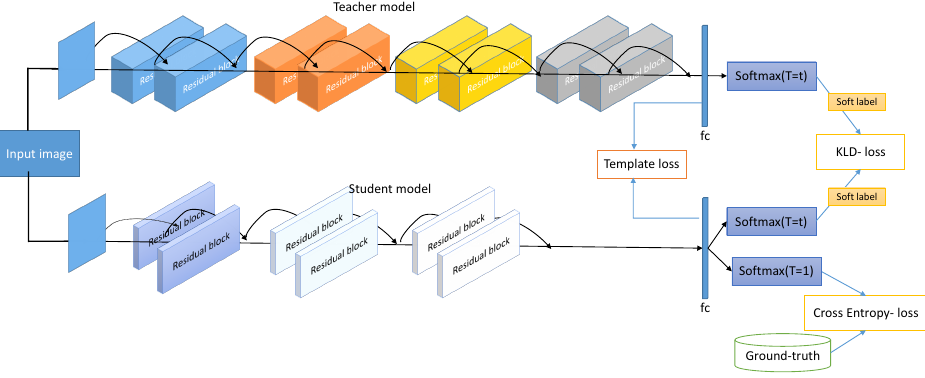
Figure 1. Overview of the proposed template-driven KD approach for periocular verification based on the ResNet architecture. Note that both the template loss and KD output loss contribute to the distillation